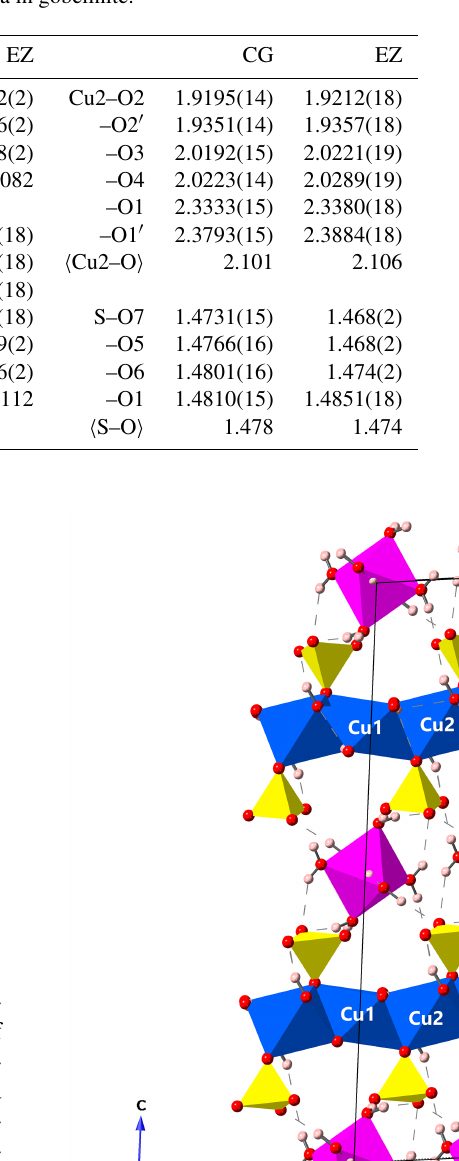
Table 4. Selected bond distances (Å) for the coordination polyhedra in gobelinite.